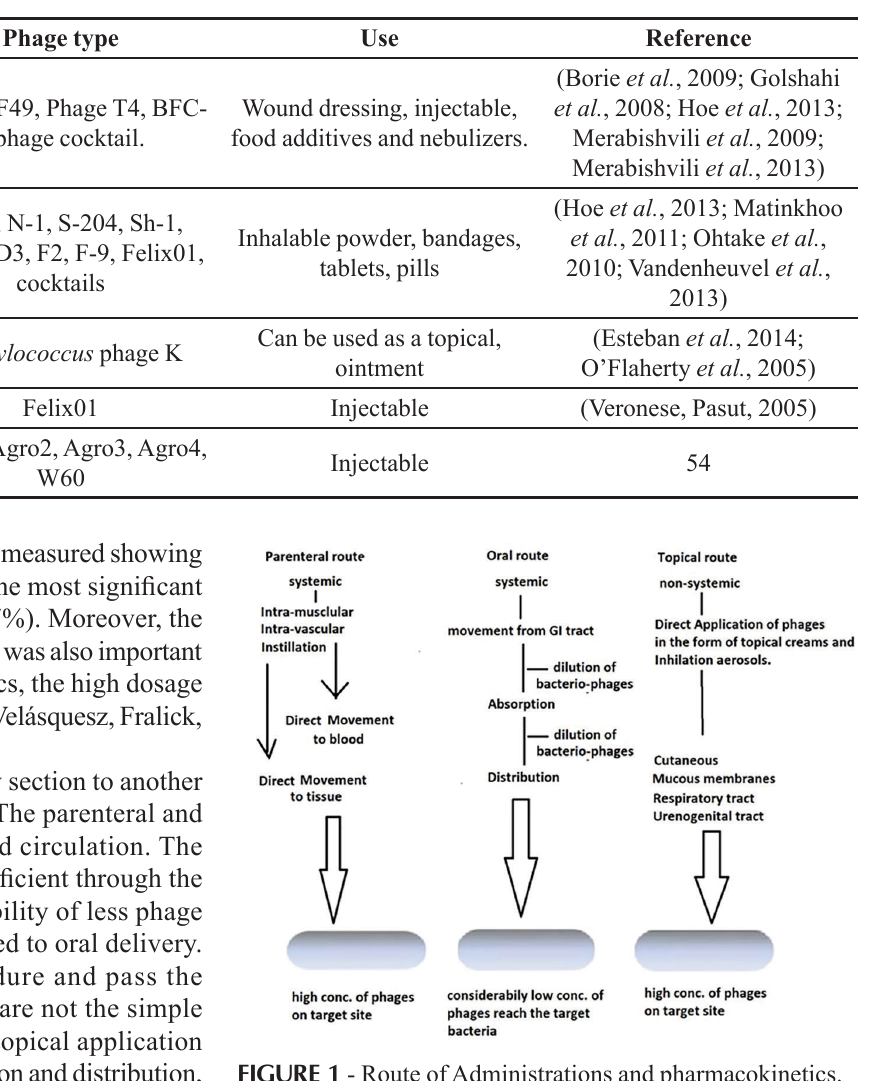
FIGURE 1 - Route of Administrations and